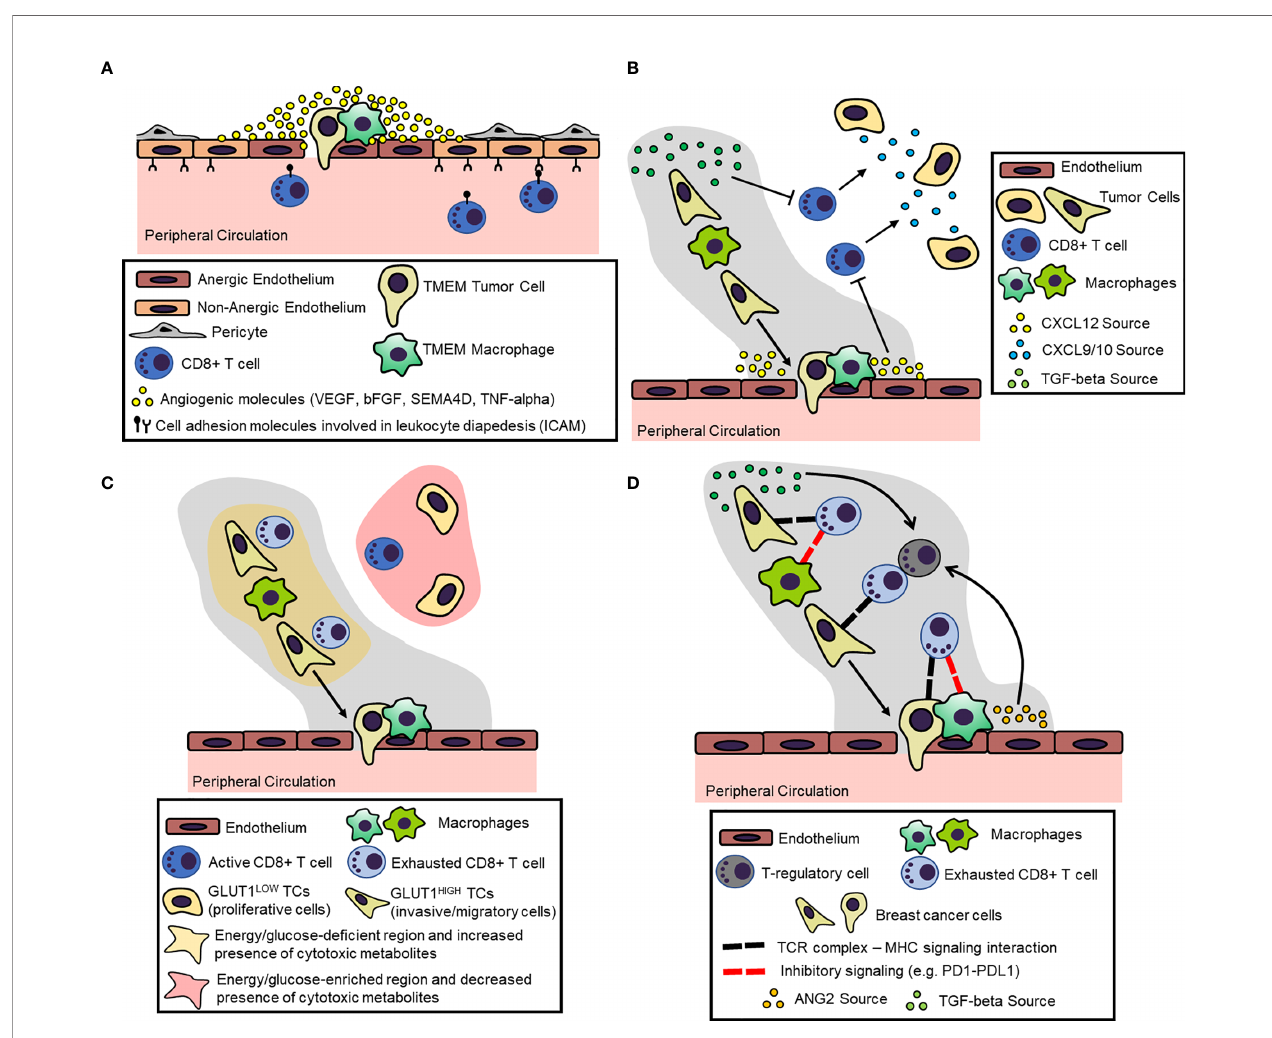
FIGURE 3 | Proposed Mechanisms for the Induction and Maintenance of an Immunosuppressive Microenvironment within the Dissemination Trajectory. (A) Dissemination trajectories as beacons of endothelial anergy. Perivascular (TMEM doorway) macrophages secrete a number of proangiogenic factors (e.g. VEGFA) in the peri-TMEM area, which downregulate cell adhesion molecules in endothelial cells critical for lymphocyte diapedesis, thus resulting in “ locally ” anergic endothelium. (B) Dissemination trajectories as crossroads for T cell exclusion. Cytokine/cytokine receptor mismatching mechanisms within the dissemination trajectories result in the exclusion of T cells. For example, prometastatic macrophages suppress the expression CXCL9/10 within the dissemination trajectories, which function as the primary chemoattractants for T cells. Instead, dissemination trajectories are characterized by the expression of other cytokines/chemokines, like TGF-beta and CXCL12, which act as repellents for T cells. (C) Dissemination trajectories as primers for metabolic burdening of T cells. Highly migratory tumor cells within the dissemination trajectories tend to upregulate glucose transporters (e.g., GLUT1), which on one hand reduces the bioavailable energy resources (i.e., glucose), while on the other hand, may produce metabolites. This metabolic landscape is burdensome for immune cells, resulting in T cell exclusion and exhaustion. (D) Dissemination trajectories as checkpoints for T cell exhaustion. Chronic TCR signaling within the dissemination trajectory along with overexpression of inhibitory ligands (e.g., PDL1) by the prometastatic macrophages may result in T-regulatory (Treg) cell expansion and CD8+ T cell